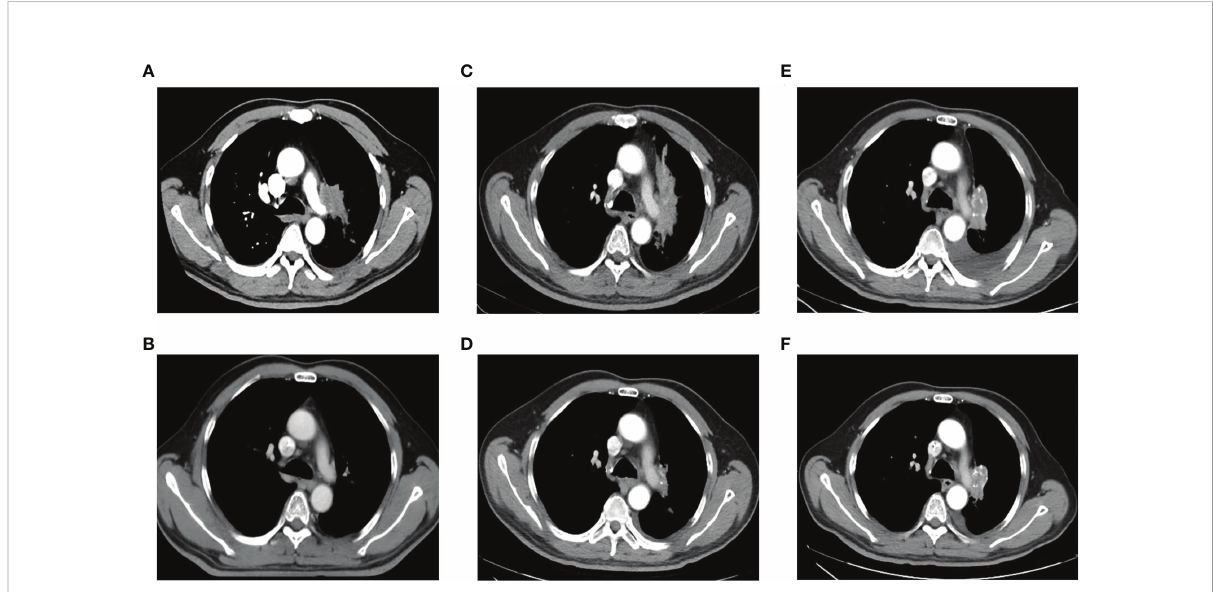
FIGURE 1 Chest computed tomography at initial diagnosis, during and after treatment. (A) . At initial diagnosis. (B) . After treatment of EP combined with radiotherapy. (C) . At the fi rst relapse. (D) . After treatment with chemotherapy plus icotinib. (E) . After icotinib resistance. (F) . After treatment of